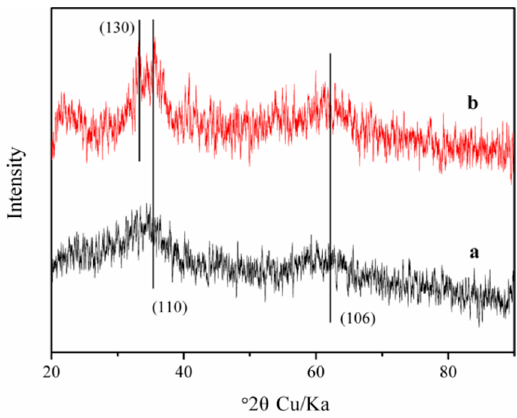
Figure 1. XRD patterns of Fhy ( a ) before and ( b ) after the photodissolution with oxalic acid.